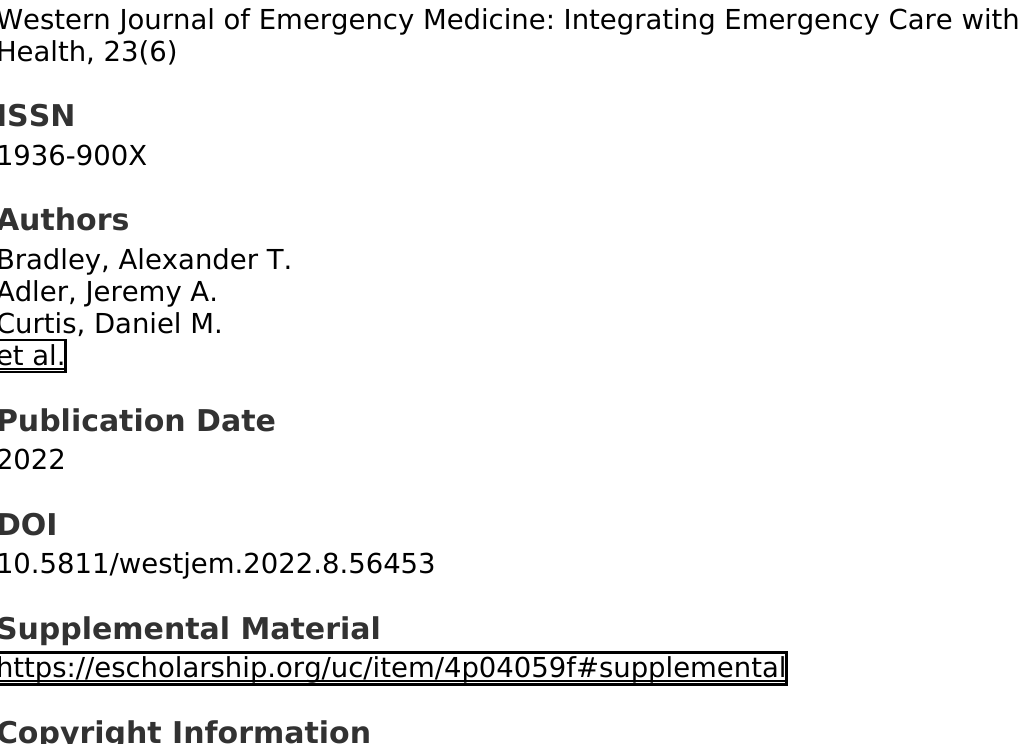
Are Oblique Views Necessary? A Review of the Clinical Value of Oblique Knee Radiographs in the Acute